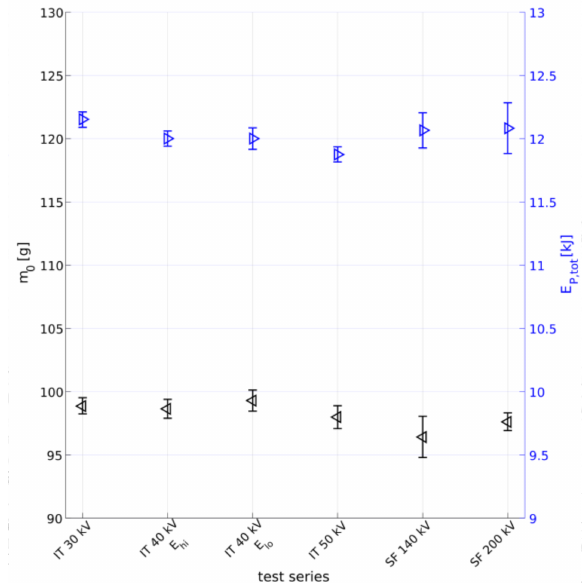
Figure 3. Sample mass (m 0 , left-pointing triangles) and total pulse energy (E P,tot , right-pointing triangles) were kept constant for all test series. The abscissa holds increasing voltage levels, generated with the two plants by ImpulsTec (IT) and SelFrag (SF).